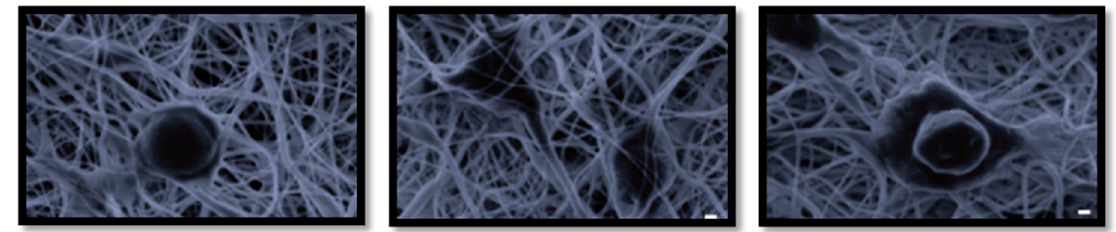
Figure 4. SEM images of GBM cells on the PCL/Gel/GO